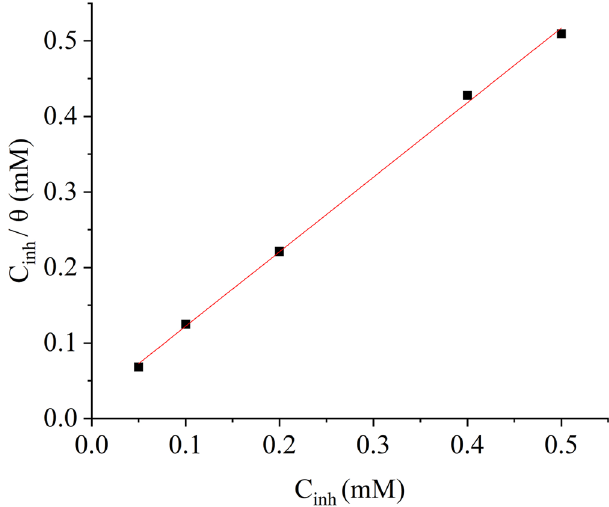
Figure 6. Langmuir adsorption model plot for nonanedihydrazide.